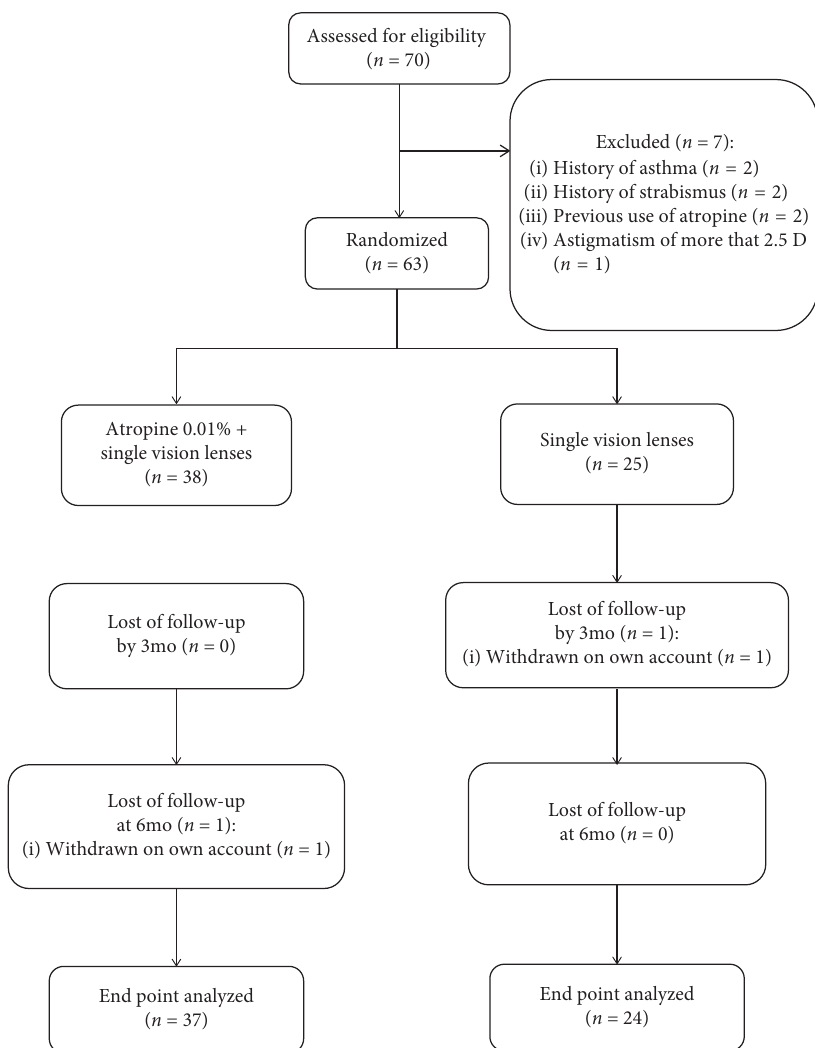
Figure 1: Consolidated Standards of Reporting Trials (CONSORT) flow diagram. D �